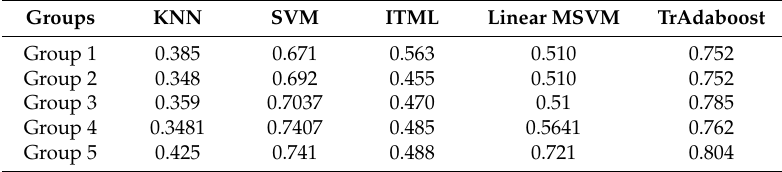
Table 5. Classification performance of five methods on different Src